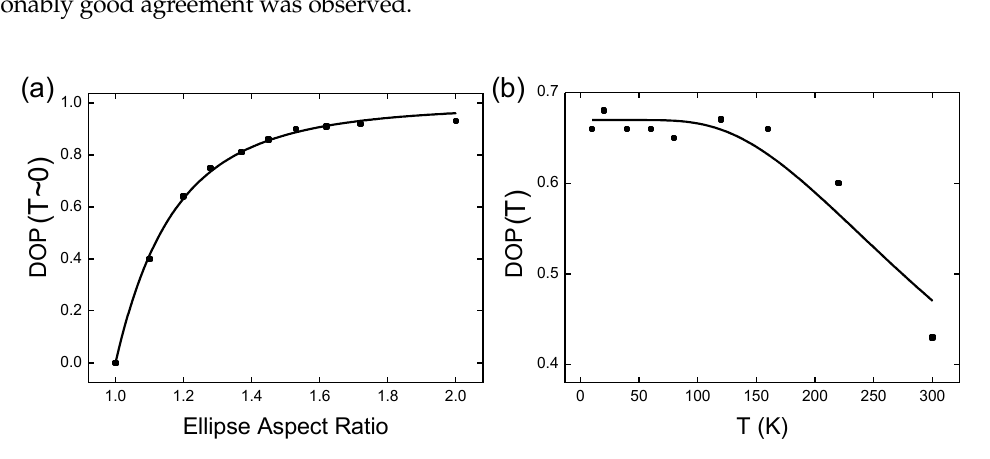
Figure 3. The comparison of the polarization model (solid lines) with experimental measurements (dots) for a sample with 1/ κ = 14 nm. It has the same epitaxial stack as sample ( a ) in Figure 2. The elliptical nanopillar has a short-axis dimension of 22 nm. ( a ) The DOP measured at T = 10 K for different ellipse aspect ratios under a low excitation condition (1 photon/pulse absorbed by the quantum disk). In ( a ), the fitting parameter α = 3.61. ( b ) The temperature dependence of DOP for the nanopillar with an ellipse aspect ratio of 1.2 under the same excitation condition as in ( a ). The fitting parameters are E 1 = 52 meV and E 1 = 58